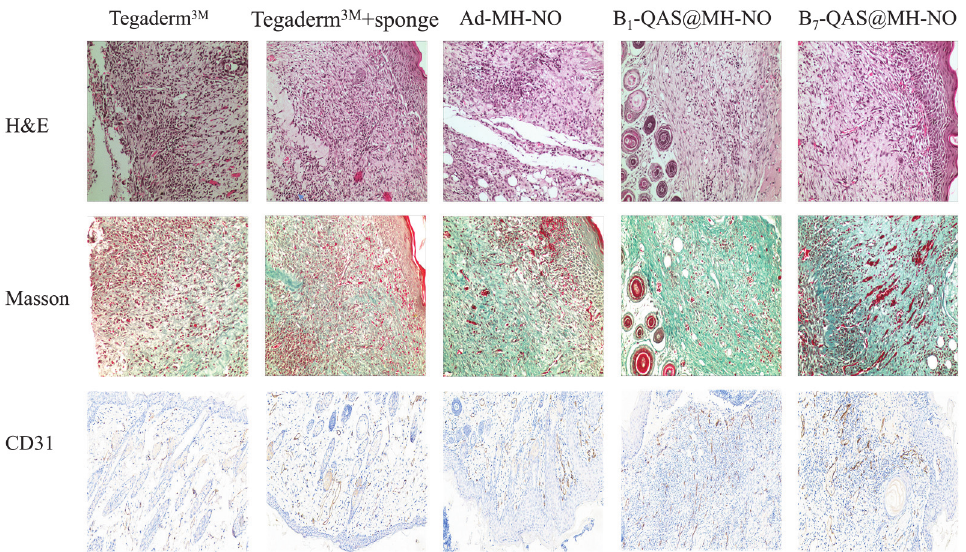
Figure 10. Histological micrograph of exposed abscess treated with Tegaderm 3M (control), Te ‐ gaderm 3M + sponge, B 7 ‐ QAS@MH ‐ NO, B 1 ‐ QAS@MH ‐ NO, Ad ‐ MH ‐ NO, Masson’s trichromatic stain